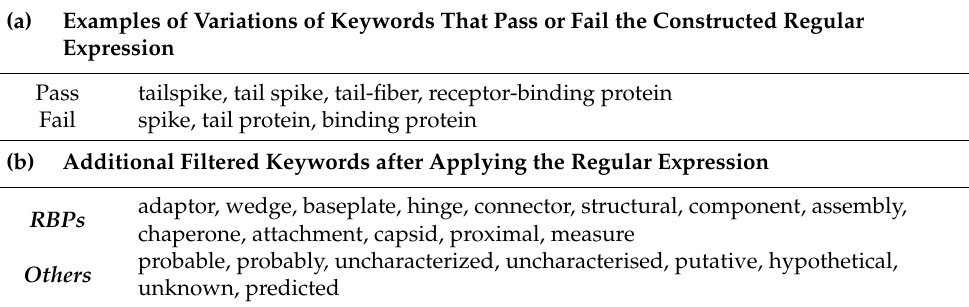
Table 1. Annotation keywords for filtering